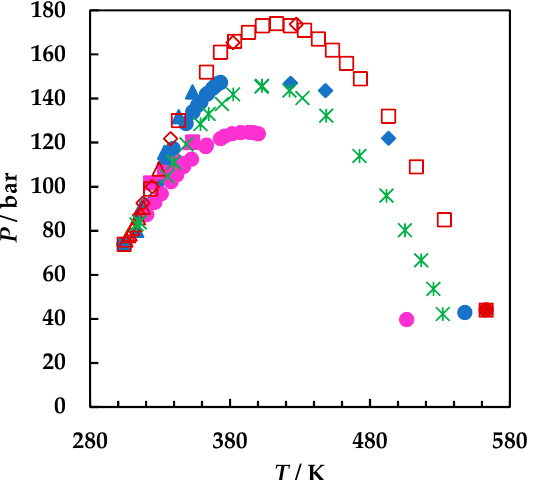
Figure 5. P – T fluid phase diagram of the carbon dioxide (1) + tert -butanol (2), carbon dioxide (1) + 2-butanol (2), carbon dioxide (1) + isobutanol (2), and carbon dioxide (1) + 1-butanol (2) binary systems. The symbols represent the binary systems as follows: CO 2 + tert -butanol ( ● , this work; ■, [28]; ▲, [29]; ◆, [30]); CO 2 + 2-butanol ( ✱ , [48]; × , [49]); CO 2 + isobutanol ( ● , this work; ▲, [27]; ◆, [26]); CO 2 + 1-butanol ( ∆ , [52]; □ , [50]; ◊ , [51]). In Table 7, we compiled the critical data and acentric factors for all butanol isomers and carbon dioxide from the three sources mentioned, while in Tables 8 and 9 we pro- vided all GEOS parameters ( m , α c , Ω a , Ω b , Ω c , and Ω d ). Table 7. Critical parameters ( T c , P c , V c ) and acentric factor ( ω ) for pure components.